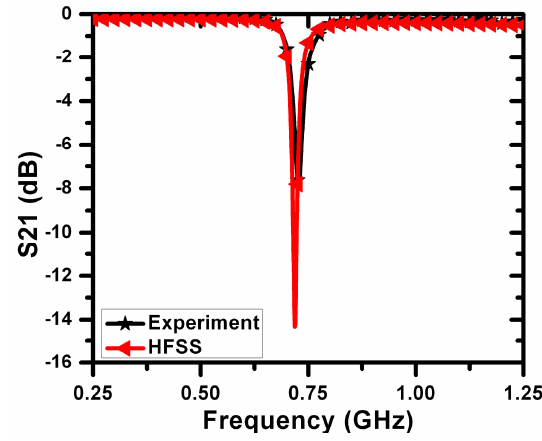
Figure 13. Minimum transmission coefficient of the sensor obtained from HFSS and measurement of 6 -mm CSRR with respect to the case without the crack after adding the two inductors of a value of 20